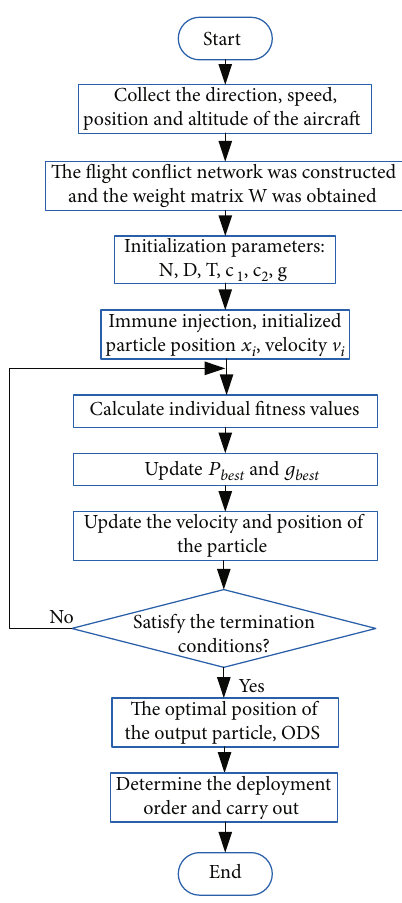
Figure 10: Con fl ict resolution